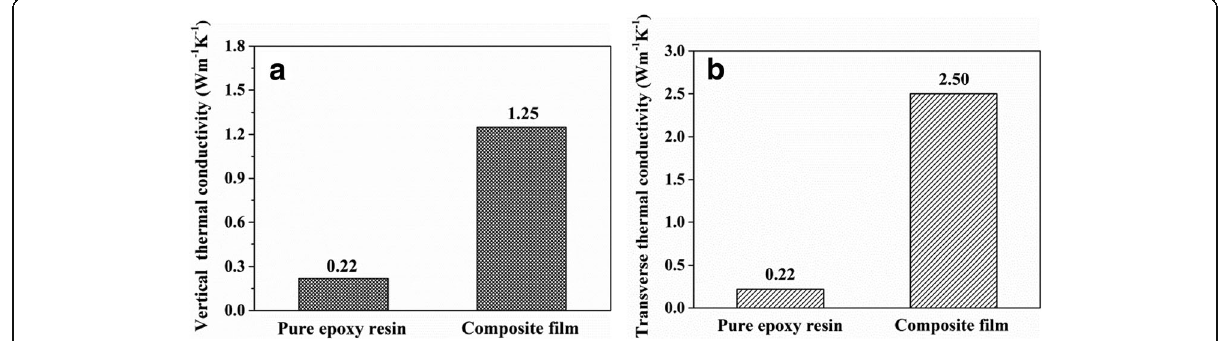
Fig. 8 Thermal property of the VACNTs/graphene composite film: a the vertical thermal conductivity and b the transverse thermal